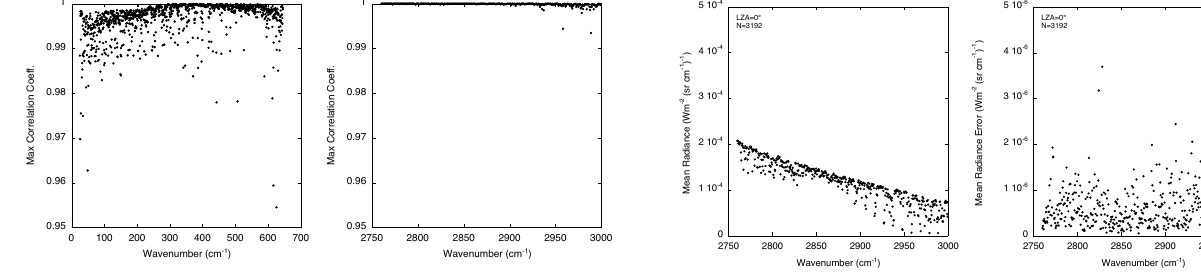
Figure 4. The maximum correlation coefficients between wavenumbers in the FIR (left) and NIR (right) and the corre- sponding predictor wavenumbers shown in Fig. 3.